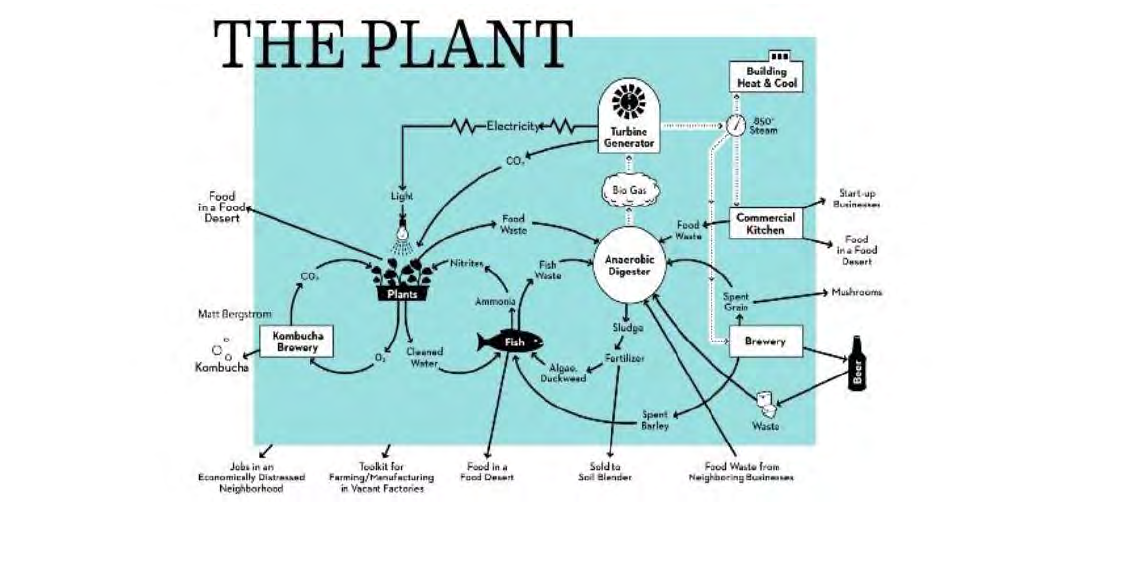
Figure 7. the Plant in Chicago: diagram representing a new kind of highly integrated organization; aninnovative urban food production program (Girardet,